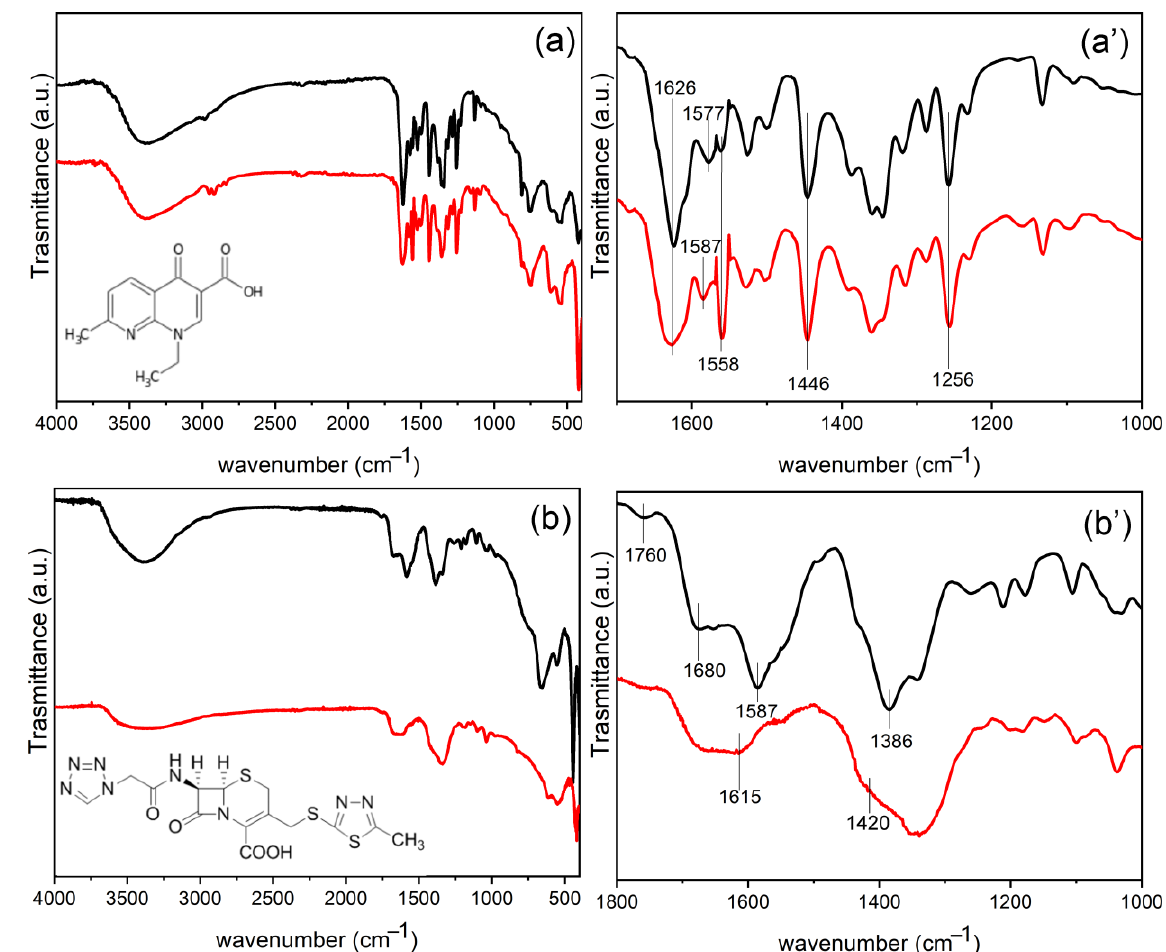
Figure 4. FT-IR of ZnAl-NAL (black line) and Ag/ZnAl-NAL (red line) ( a ), enlargement in the spectral range 1700 – 1000 cm −1 ( a’ ); FT-IR of ZnAl-CFZ (black line) and Ag/ZnAl-CFZ (red line) ( b ), enlargement in the spectral range 1800 – 1000 cm −1 ( b’ ). The structural formulae of nalidixic acid ( a ) and cefazolin ( b ) are reported. and cefazolin ( b ) are